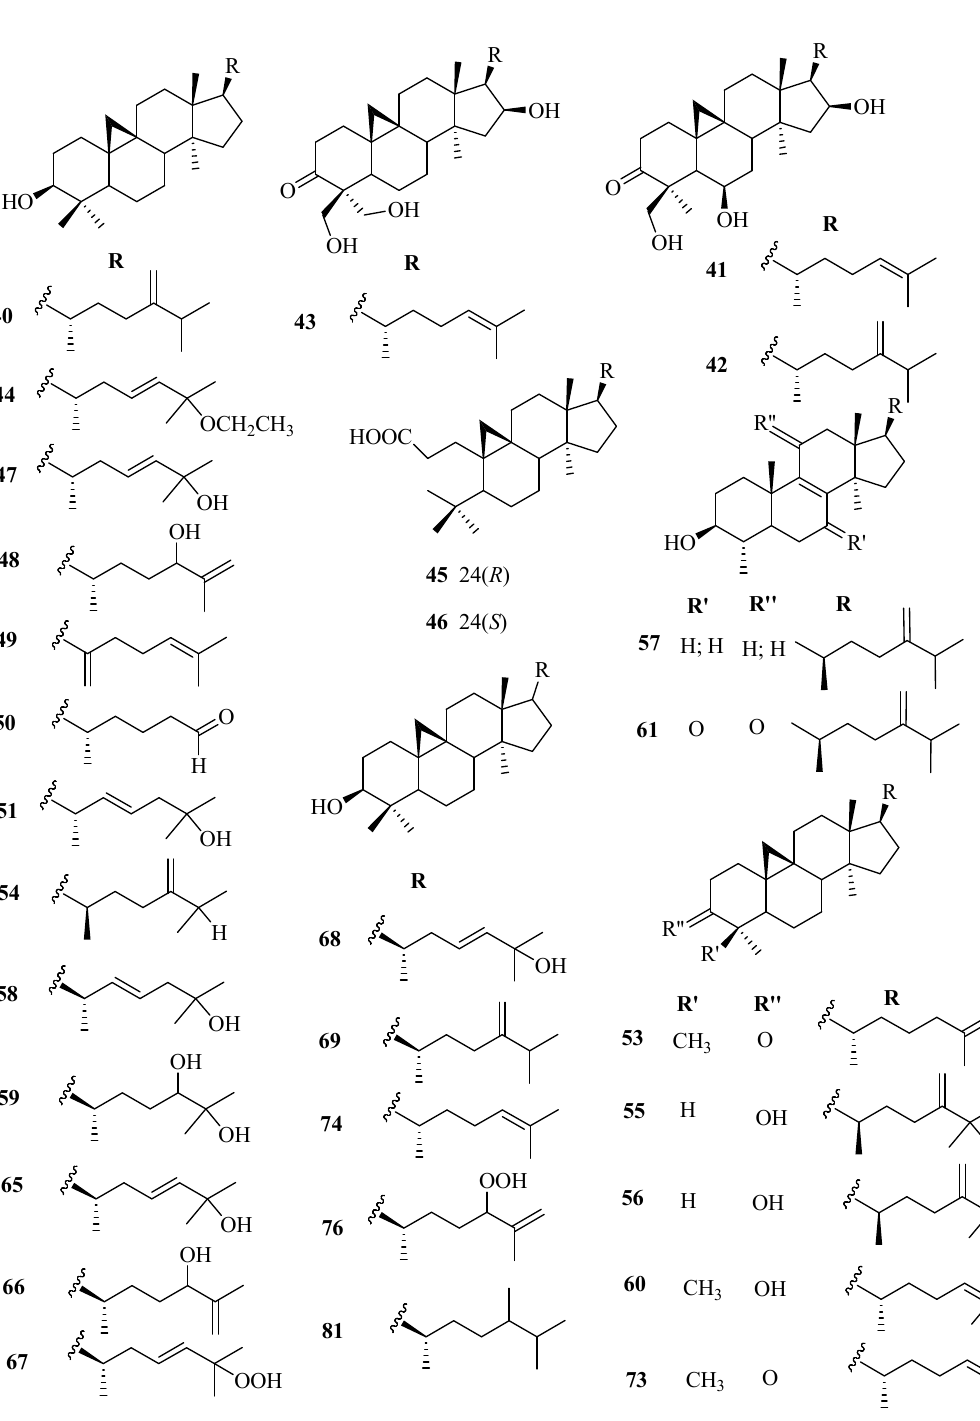
Figure 3. Chemical structures of cycloartane triterpenoids isolated from genus Euphorbia.